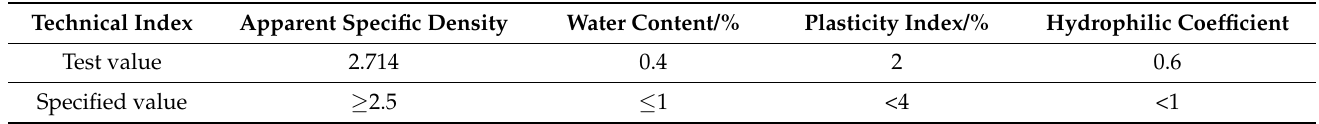
Table 6. Basic technical indexes of mineral powder [13].